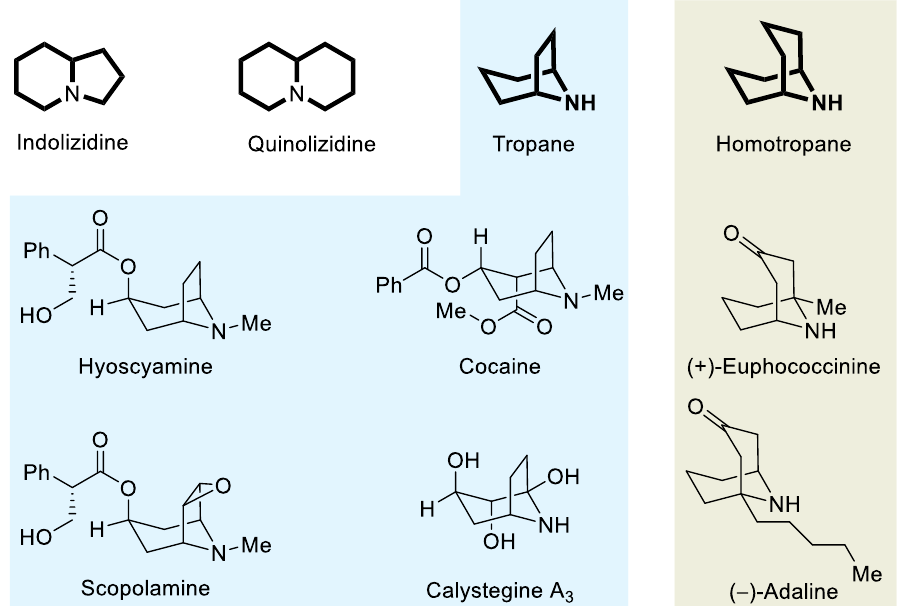
Figure 1. Representative tropane and homotropane alkaloids.